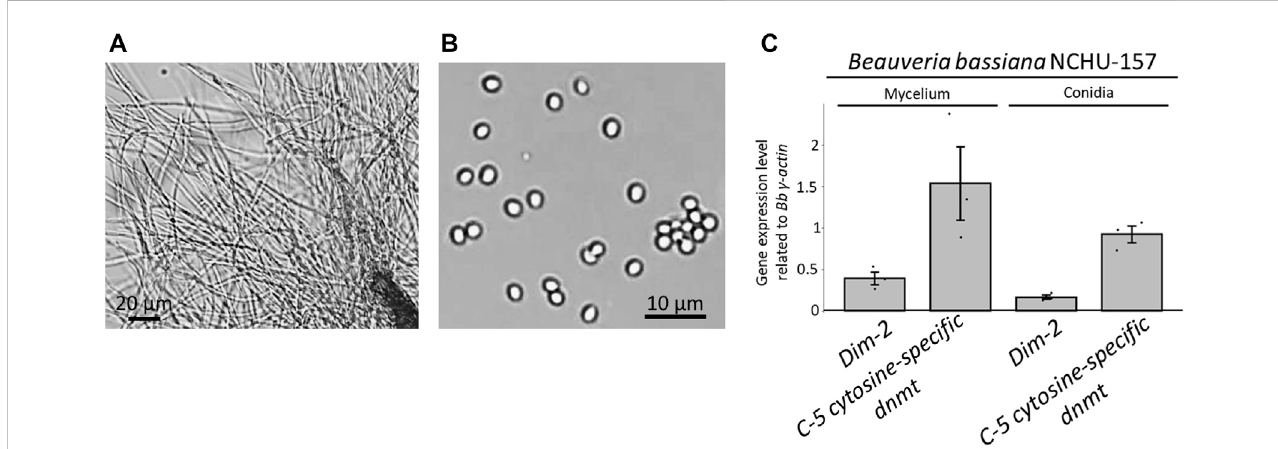
FIGURE 2 Two life stages of Bb-NCHU-157 and the relative gene expression levels of two DNMTs (e.g., Dim-2 and C-5 cytosine speci fi c DNA methylase ) in two differentlifestagesofBb-NCHU-157. (A) Myceliumstagewith 3 daysofcultureon¼SDAplates, (B) conidiastagewith7 daysofcultureon¼SDAplates,and (C) relative gene expression levels of Dim-2 and C-5 cytosine-speci fi c DNA methylases in the mycelium and conidial